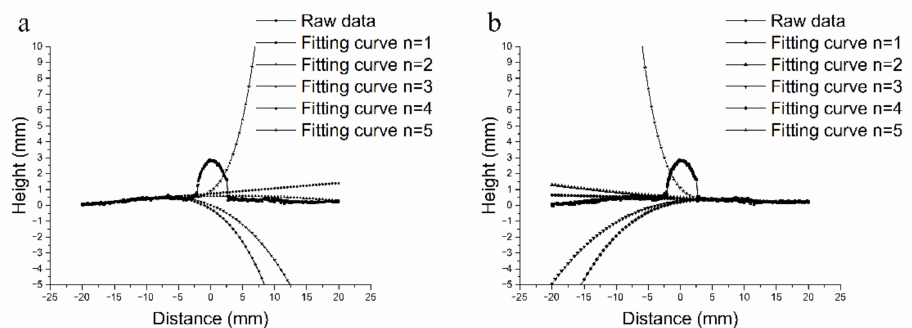
Figure 3. Fitting results. ( a ): left surface. ( b ): right